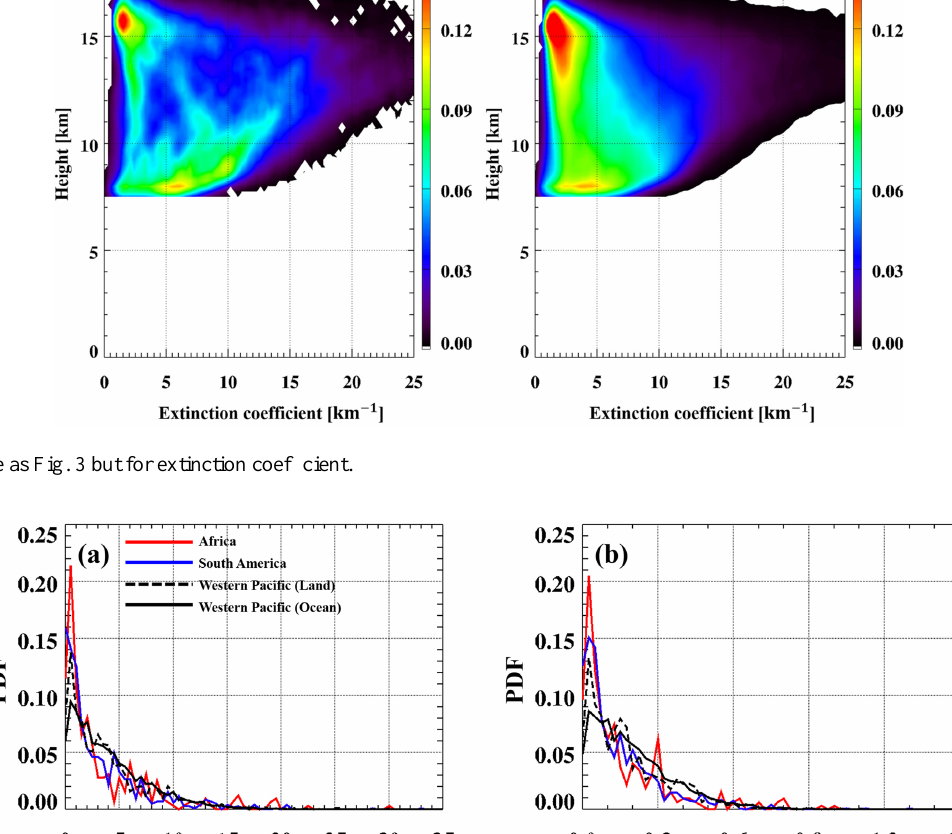
Figure 11. PDF distributions of CALIPSO-estimated (a) ice water path (IWP) and (b) cloud optical thickness